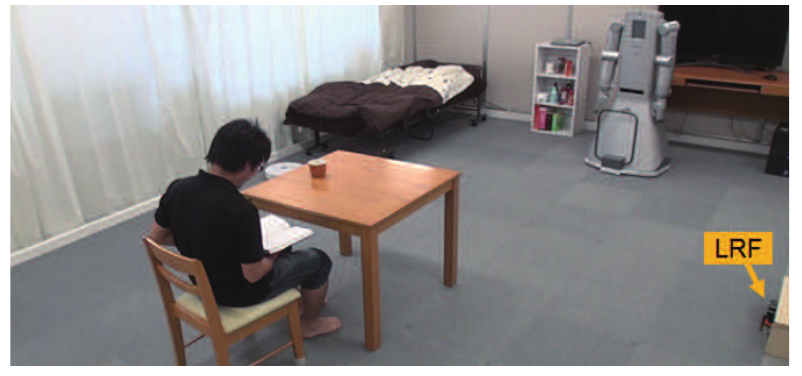
Figure 3. Objects in daily environment.